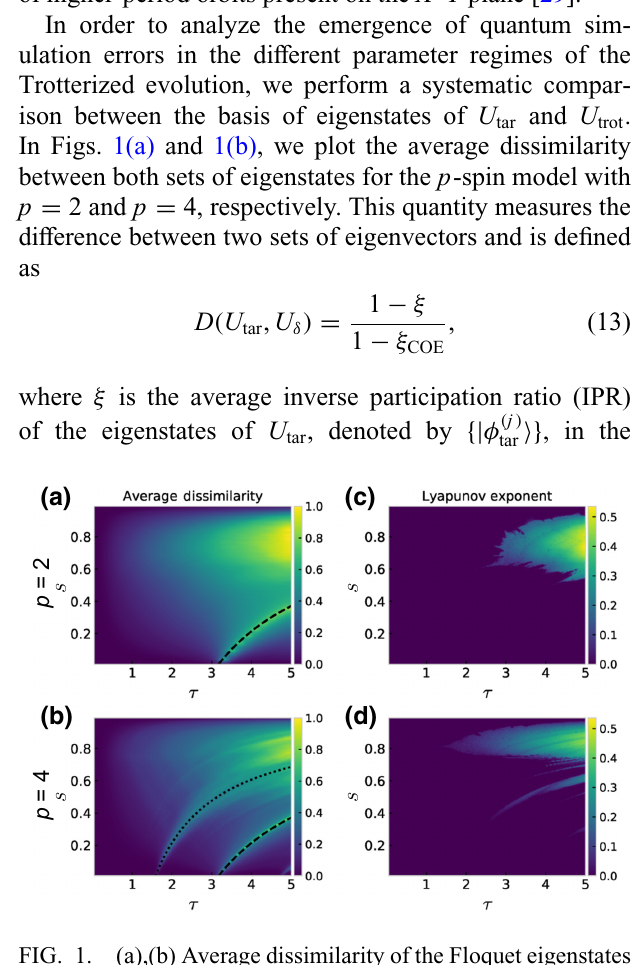
FIG. 1. (a),(b) Average dissimilarity of the Floquet eigenstates of H δ (τ) with respect to the eigenstates of the p -spin Hamilto- nian, Eq. (13). (c),(d) Largest Lyapunov exponent of the classical stroboscopic map associated with the Floquet map of the simula- tor as a function of (τ , s ) . In both cases we show the results for p = 2 (top) and 4 (bottom), and N = 128. The dashed and dot- ted lines in (a) and (b) have the form s (τ) = 1 − α/τ with α = π , π/ 2, respectively. These represent regions of structural insta- bility that are not associated with chaos as the largest Lyapunov exponent corresponding to these regions is